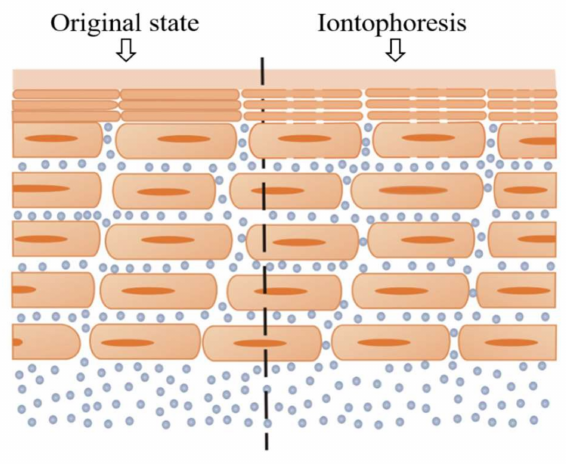
Figure 8. Schematic illustration of electroporation showing that new channels were made after the electroporation